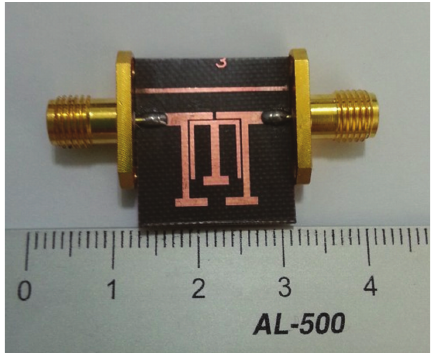
Figure 6: Photograph of the fabricated dual-band BPF.